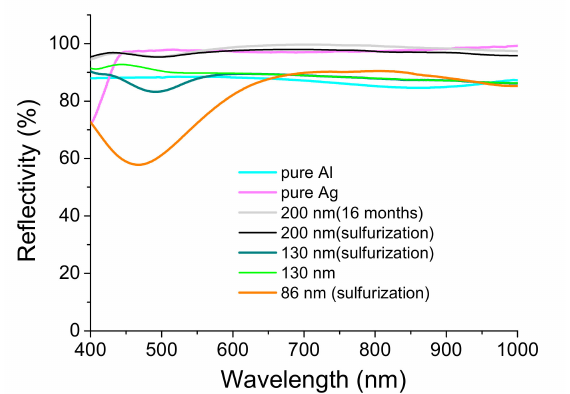
Figure 7. The reflectivity of sulfurized or untreated Ag-coated